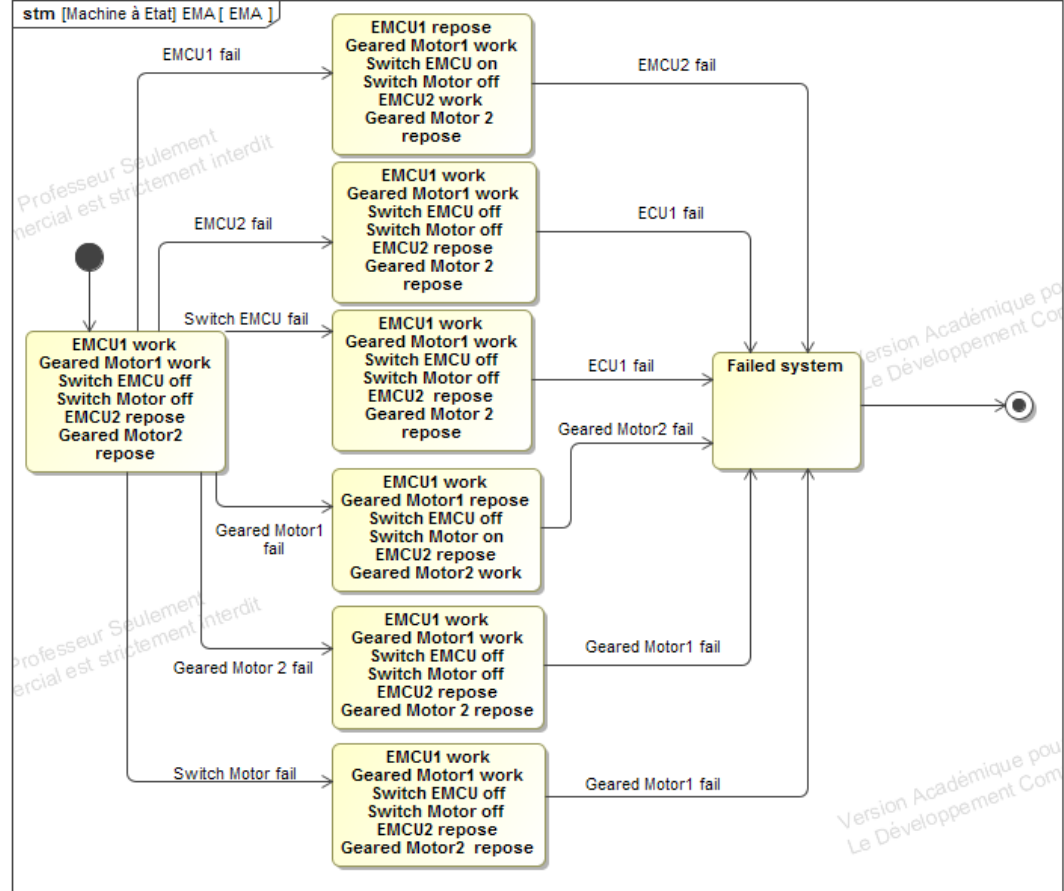
Figure 9. State machine of the EMA